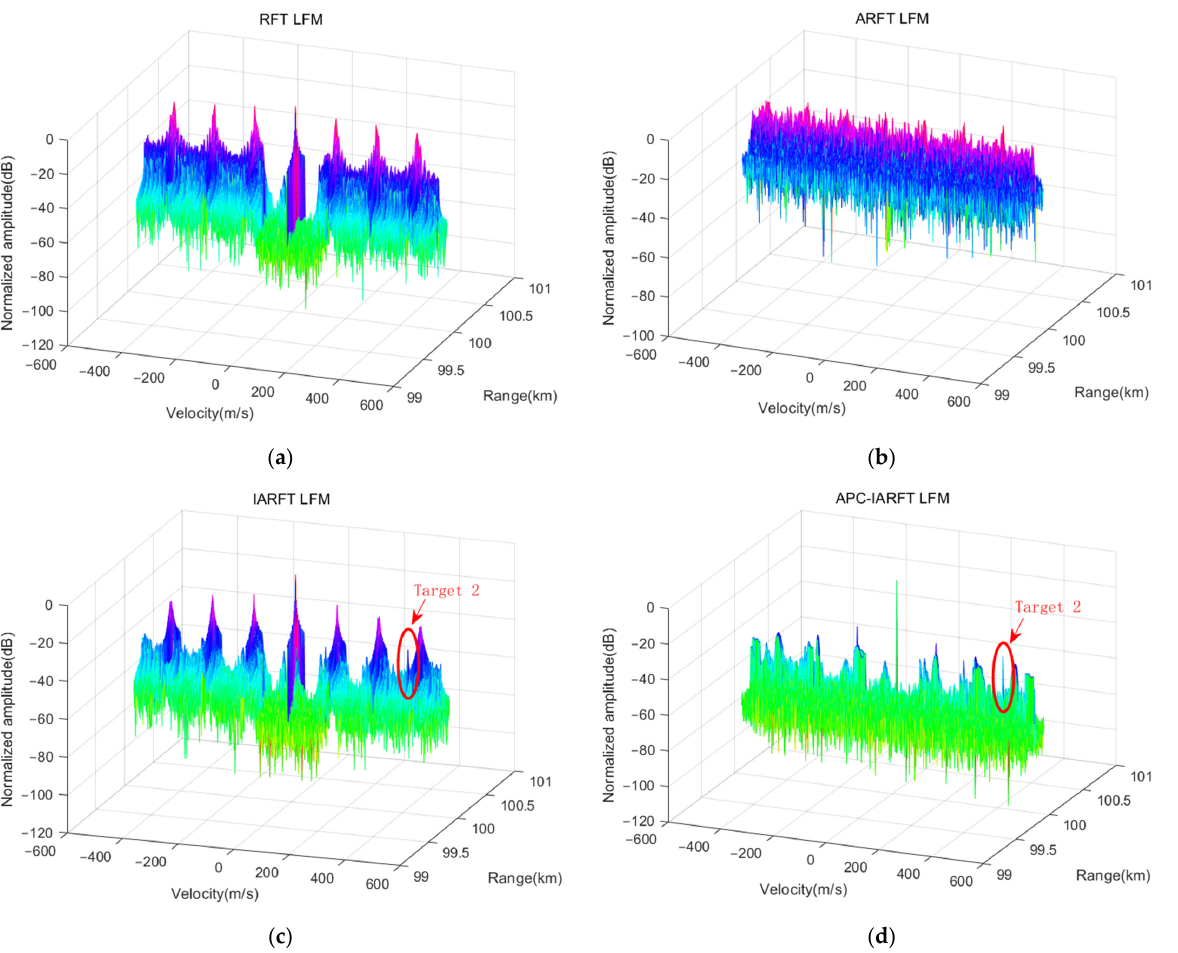
Figure 5. Stereogram output of four methods in Scenario 1. ( a ) Output of RFT; ( b ) Output of ARFT; ( c ) Output of IARFT; ( d ) Output of APC-IARFT.